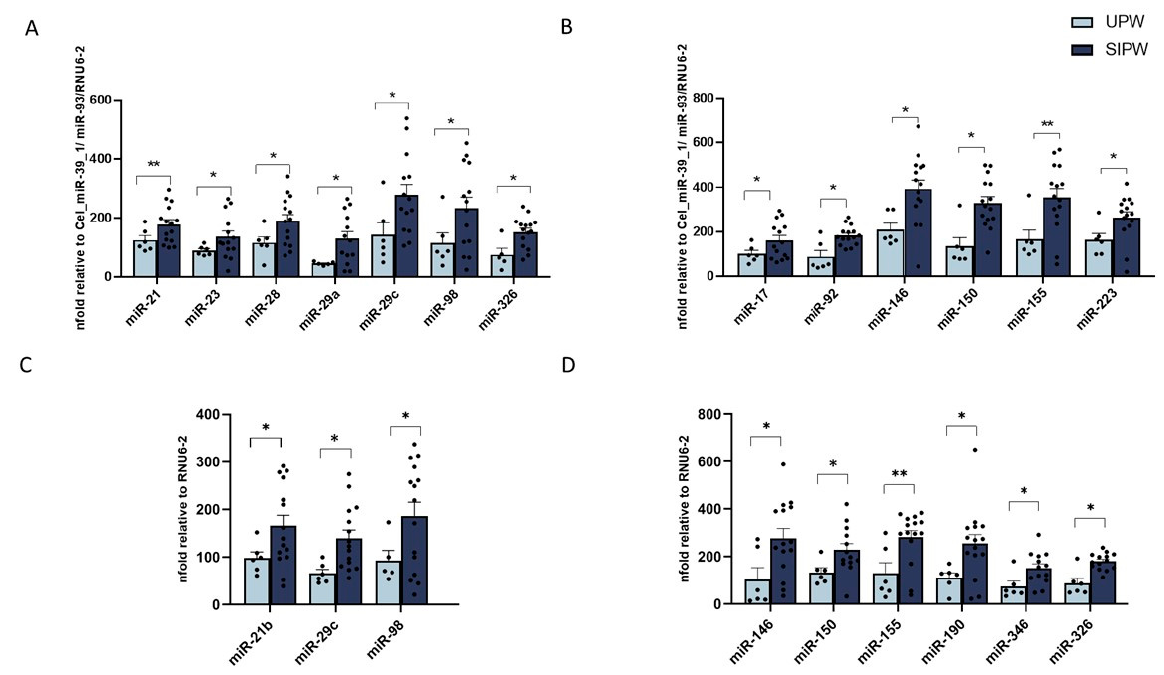
Figure 2. MiRNA expression analysis in plasma and placenta biopsies by PCR array. Analyses of miRNA with antiviral ( A , C ) and with immunological function ( B , D ) was performed on plasma ( A , B ) and placenta biopsies ( C , D ) of 6 UPW (light blue bars) and 15 SIPW (blue bars). Results were calculated relative to the arithmetical mean of the references available in the arrays (Cel_miR-39_1, miR-93 and RNU6-2 for plasma and RNU6-2 for placenta biopsies). Values are mean ± SEM. Significance is indicated as follows: * = p < 0.05 and ** = p < 0.01.